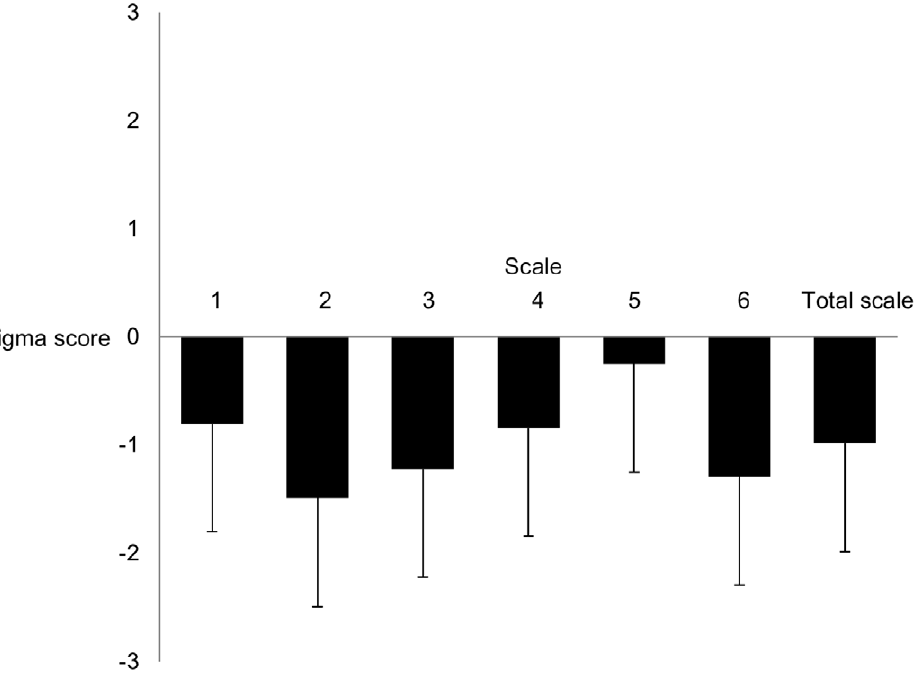
Figure 1. Mean stigma scores and standard deviations on the subscales. Subscale 1: Reliability and Social Functioning; Subscale 2: Malingering and Misuse of Medication; Subscale 3: Ability to Take Responsibility; Subscale 4: Norm-violating and Externalizing Behavior; Subscale 5: Consequences of Diagnostic Disclosure; Subscale 6: Etiology. Higher stigma scores indicate increased stigmatizing beliefs; All subscales differ significantly (p , .05) from each other with the exception of the comparison between 1 and subscale 4 and between subscale 3 and 6 (p .